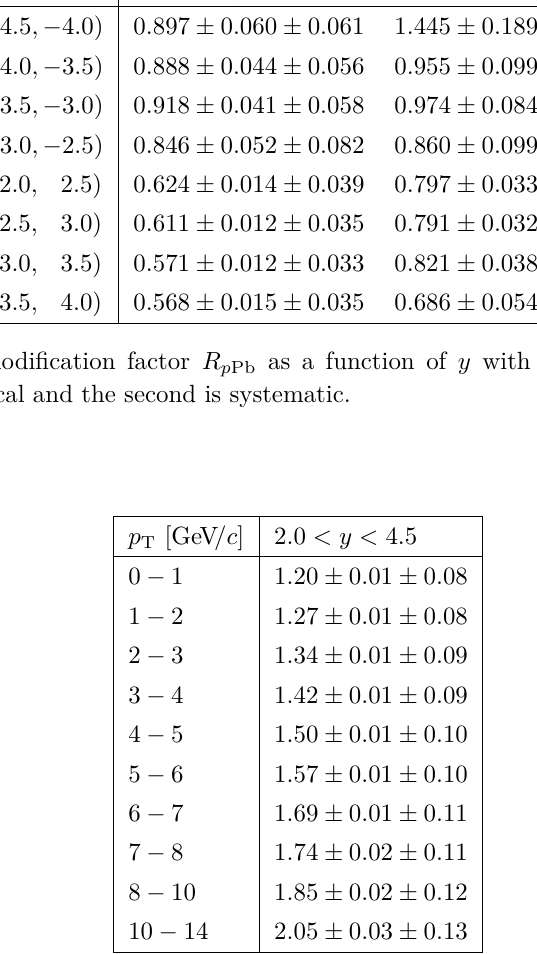
Table 10 . Cross-section ratios between 8 TeV and 5 TeV measurements for prompt J/ψ mesons as a function of p T with 2 . 0 < y < 4 . 5 . The first uncertainty is statistical and the second is systematic.